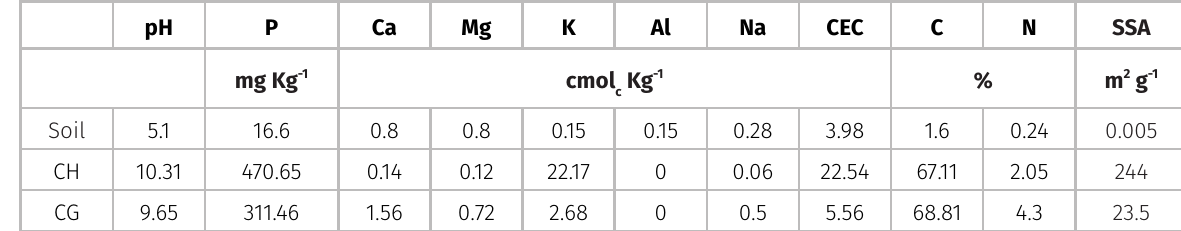
Table I. Physico-chemical properties of Entisol and biochar from coffee husk (CH), and coffee grounds (CG). pH P Ca Mg